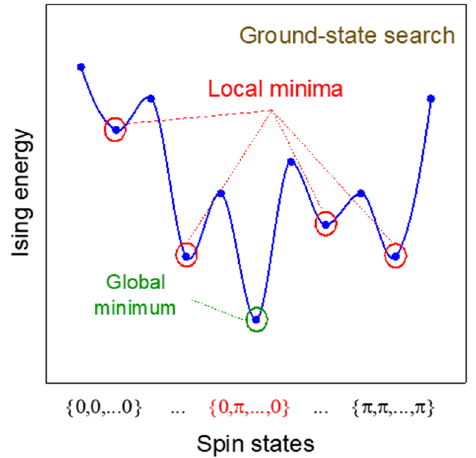
Figure 10. Schematic diagram of oscillator system